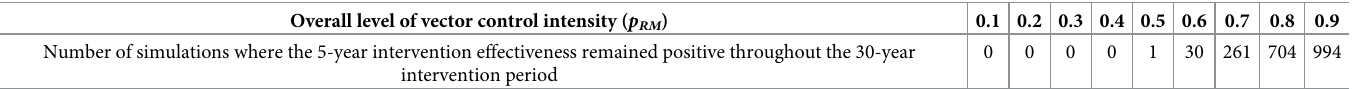
Table 2. Number of simulations where the 5-year intervention effectiveness remained positive throughout the entire 30-year intervention period. For each overall level of vector control intensity, a total of 1000 simulations were performed. Overall level of vector control intensity ( p RM